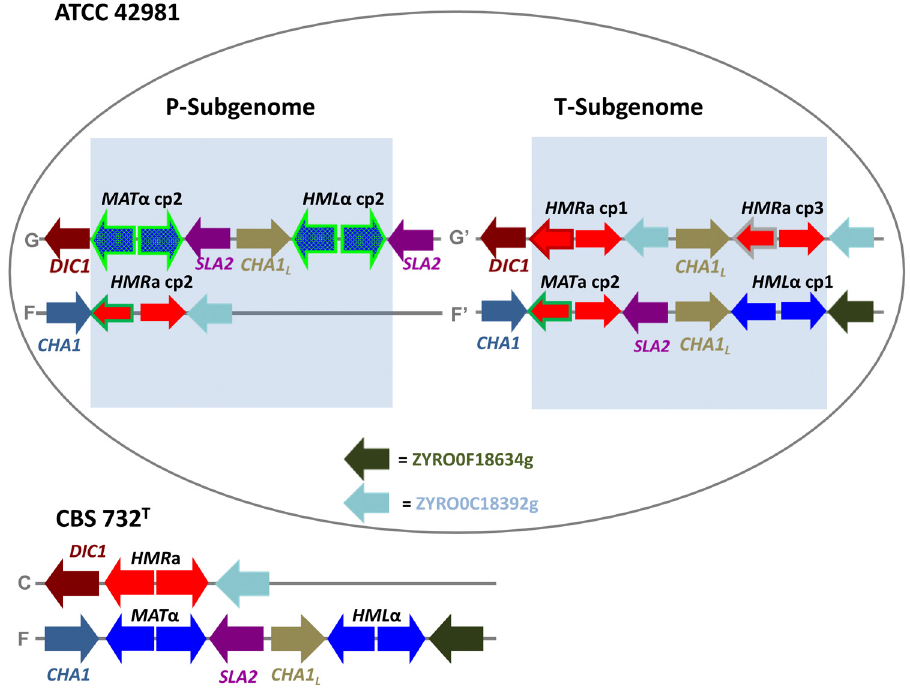
Fig 6. Inferred genomic organization around MAT -like loci in the ATCC 42981 allodiploid genome. Two sex homologous/homeologous chromosome pairs are depicted, namely F/F ’ and G/G ’ . Chromosome G bears the MAT α copy 2 expression locus, which is linked to the putative silent cassettes HML copy 2, whereas chromosome F ’ bears the MAT a copy 2 expression locus, which is linked to the putative silent cassette HML copy 1. Chromosomes F and G ’ harbour three a -idiomorph HMR loci, which differ for MAT a 2 genes. The HMR copy 2 locus is on chromosome F, while the HMR copies 1 and 3 loci are on chromosome G ’ . Blue arrows represent Z . rouxii -like (blue bordered) and Z . sapae -like (light green bordered) α -idiomorph loci. Red arrows indicate a -idiomorph loci with different MAT a 2 genes: copy 1 (dark red surrounded), copy 2 (dark green), copy 3 (grey), respectively. Chromosomal organization of the three-cassette system in Z . rouxii haploid strain CBS 732 T was reported for comparative purposes according to Souciet et al. [34]. CHA1 L indicates the ZYRO0F18524g locus, while dark green and light blue arrows indicate the ZYRO0F18634g and ZYRO0C18392g loci, respectively at the right side of mating-type